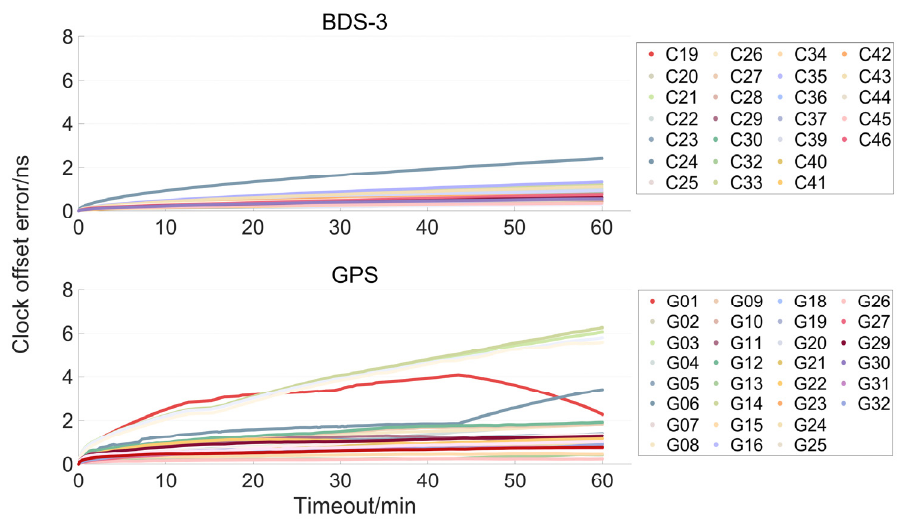
Figure 11. RMSE of the extended clock corrections of the BDS-3 and GPS satellites in the radial, along-, and cross-track directions on DOY 192 in 2022.